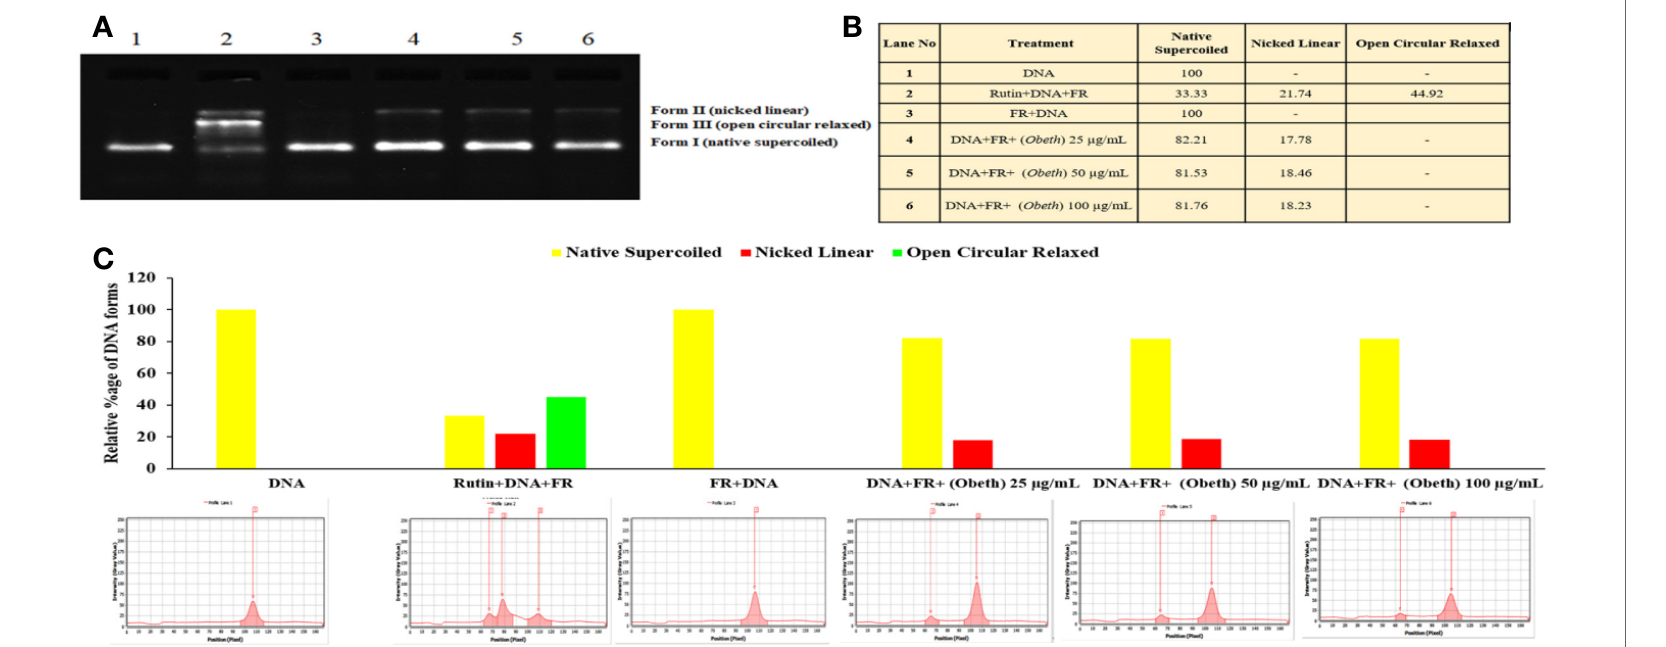
FIGURE 2 | Effect of Obeth from O. bracteata on DNA protection against oxidative damage caused by Fenton ’ s reagent (FR) in DNA nicking assay. (A) Relative mobility of different forms of plasmid DNA exposed to Obeth extract in electrophoresis. Lane 1: Negative control (pBR322 DNA + distilled water); Lane 2: Positive control (pBR322 DNA + FR); Lane 3: pBR322 DNA + FR + 100 µg/mL rutin; Lanes 4, 5, 6: pBR322 DNA + FR + 25, 50, 100 µg/mL Obeth fraction respectively. (B) Densitometric analysis showing relative percentage of different DNA forms in plasmid after treatment with various concentrations of Obeth fraction in the form of table and (C) graph respectively (software used = Lab Image). CN = Control, FR=Fenton